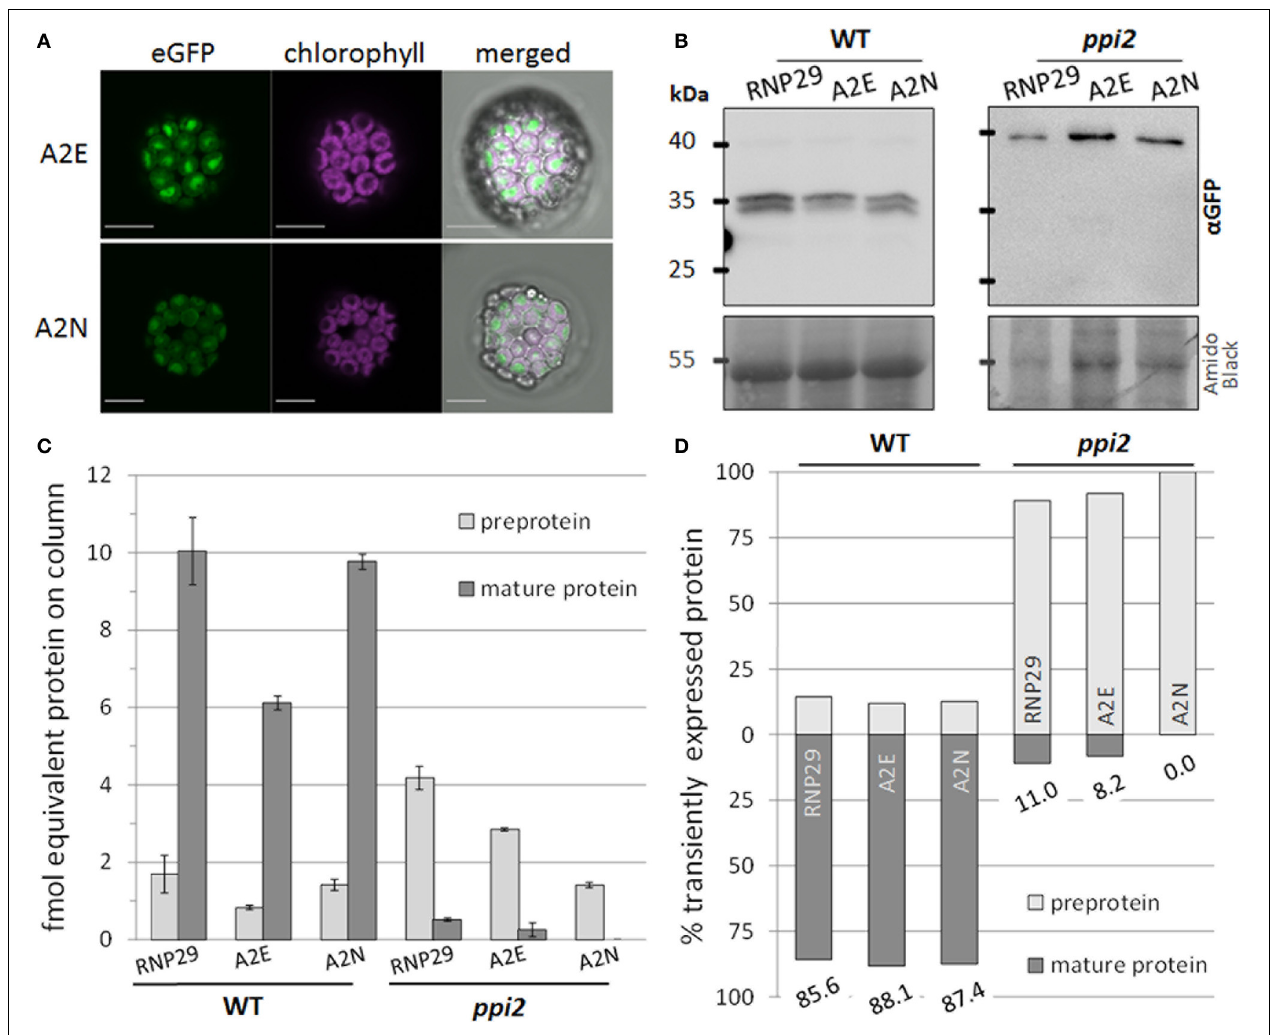
FIGURE 3 | Import efficiency of different RNP29 constructs. The second amino acid of RNP29 1 − 100 :eGFP (RNP29) Ala was replaced by Glu in A2E or Asn in A2N. Import efficiency of the substrates was analyzed in transiently transformed wild type (WT) and ppi2 protoplasts with different methods, showing the import efficiency of the A2E and the A2N construct. (A) CLSM of transiently transformed protoplasts,